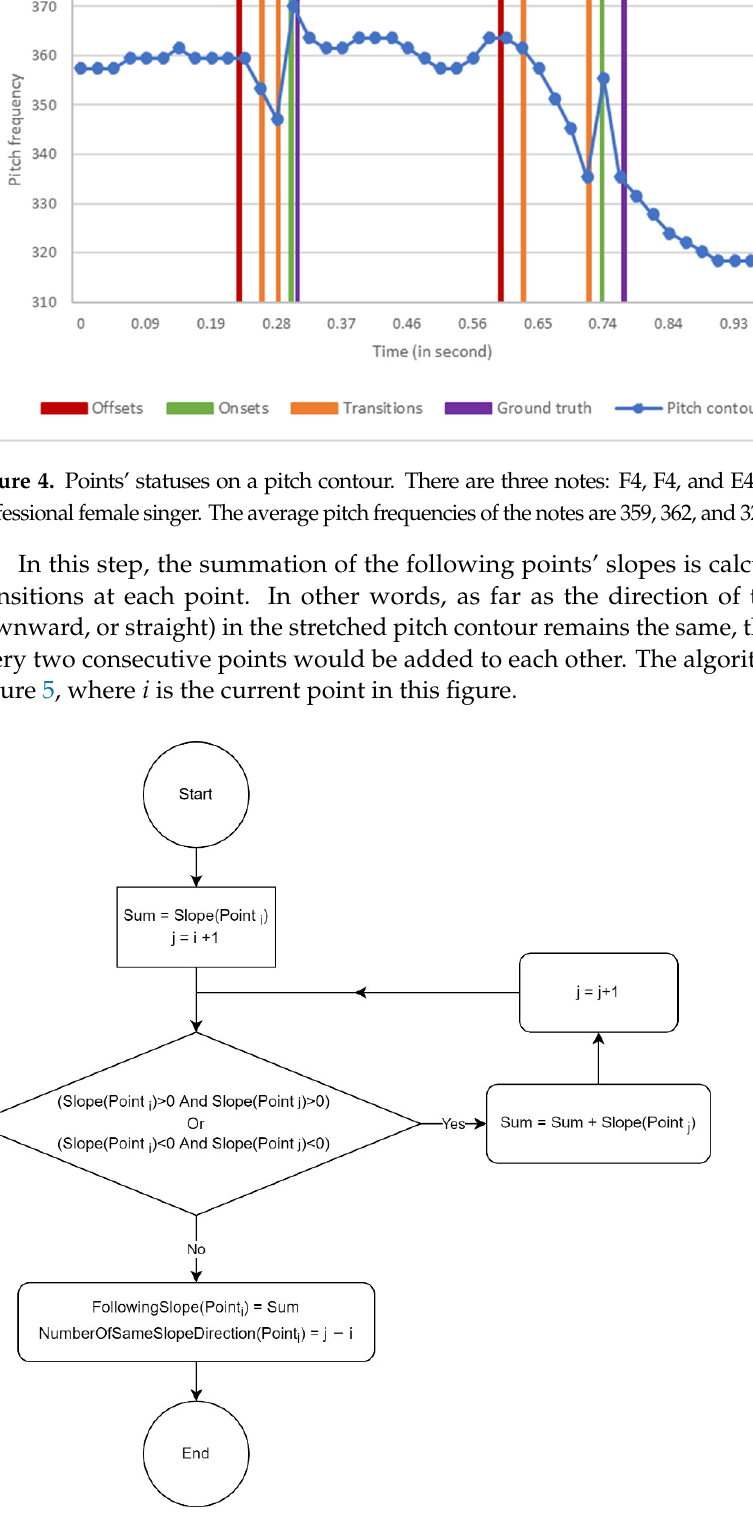
Figure 5. Calculating the summation of the following slopes of the differentiated